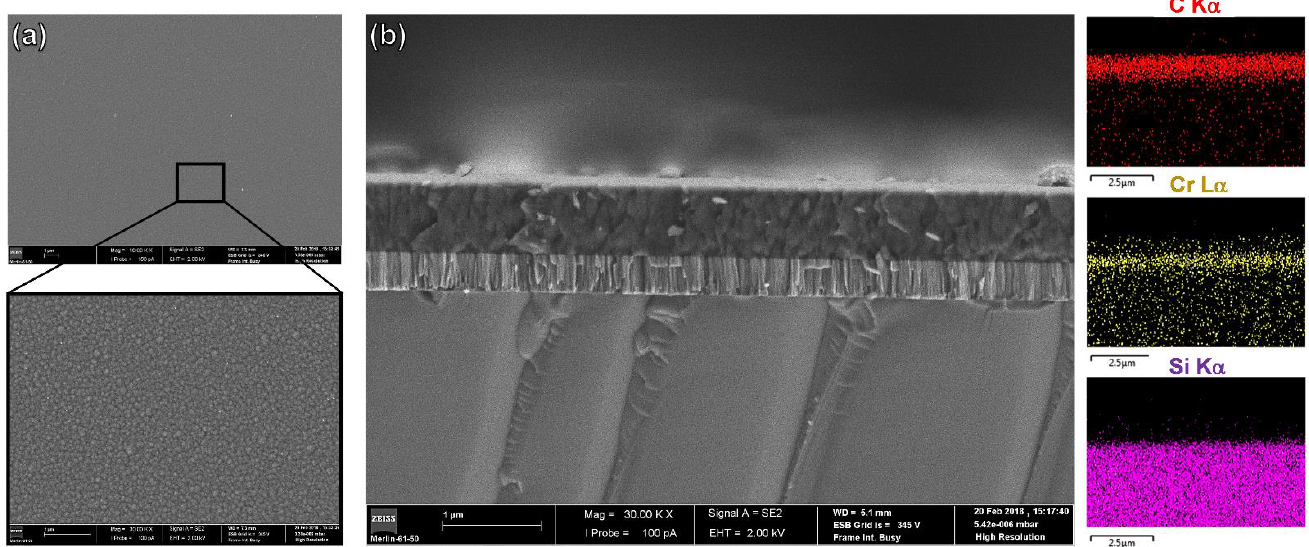
Figure 6. SEM ( a ) Surface and ( b ) cross-section micrographs of the a-C:H coating deposited on Si substrates and the corresponding EDS elemental distribution maps.